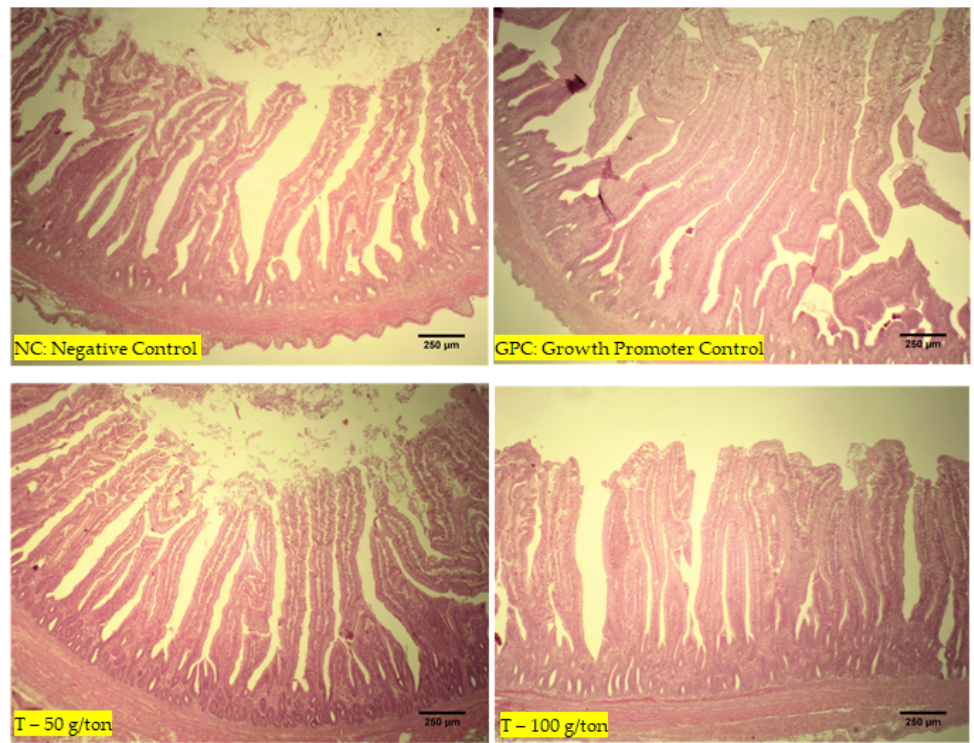
Figure 2. Images of the intestine (jejunum) of chickens from the four treatment groups at 42 days of age, all without alterations or lesions.